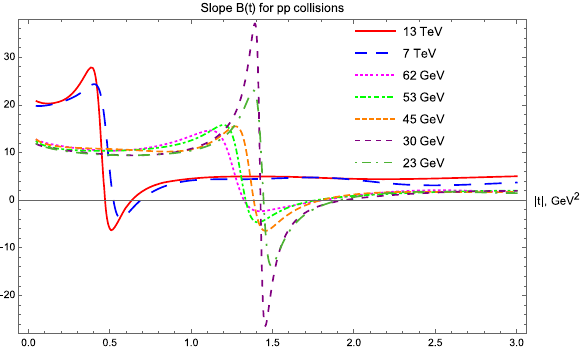
Fig. 12 Slope parameter B ( t ) for elastic p ¯ p collisions